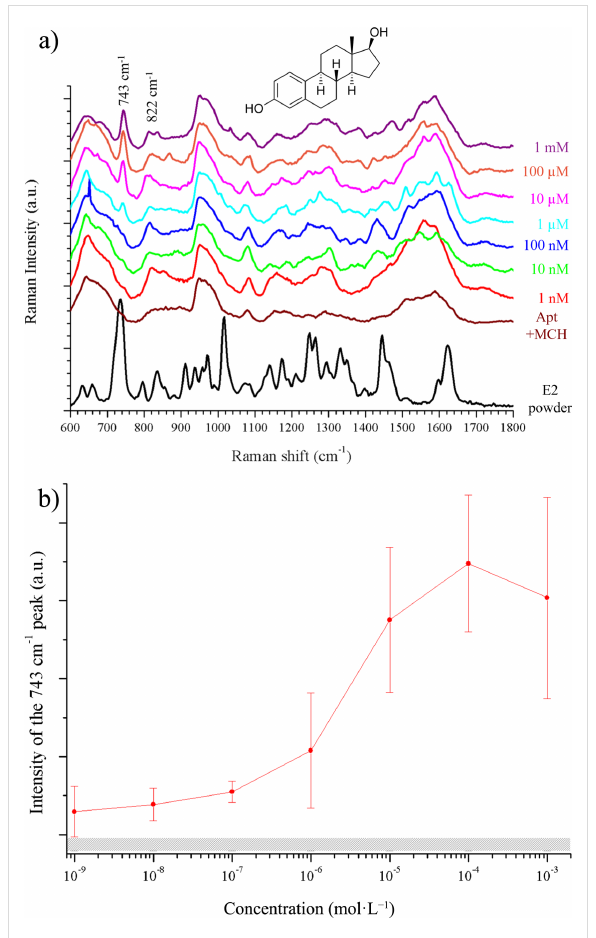
Figure 7: (a) Raman spectrum of E2 (black), SERS spectra of the empty sensor (Apt+MCH) and increasing concentrations of E2 on TiO 2 /Au 6 nm (annealed). The molecular structure of E2 is presented at the top. (b) Intensity of the peak at 743 cm − 1 for increasing concen- trations of E2. The hatched rectangle represents the intensity of the empty sensor and its